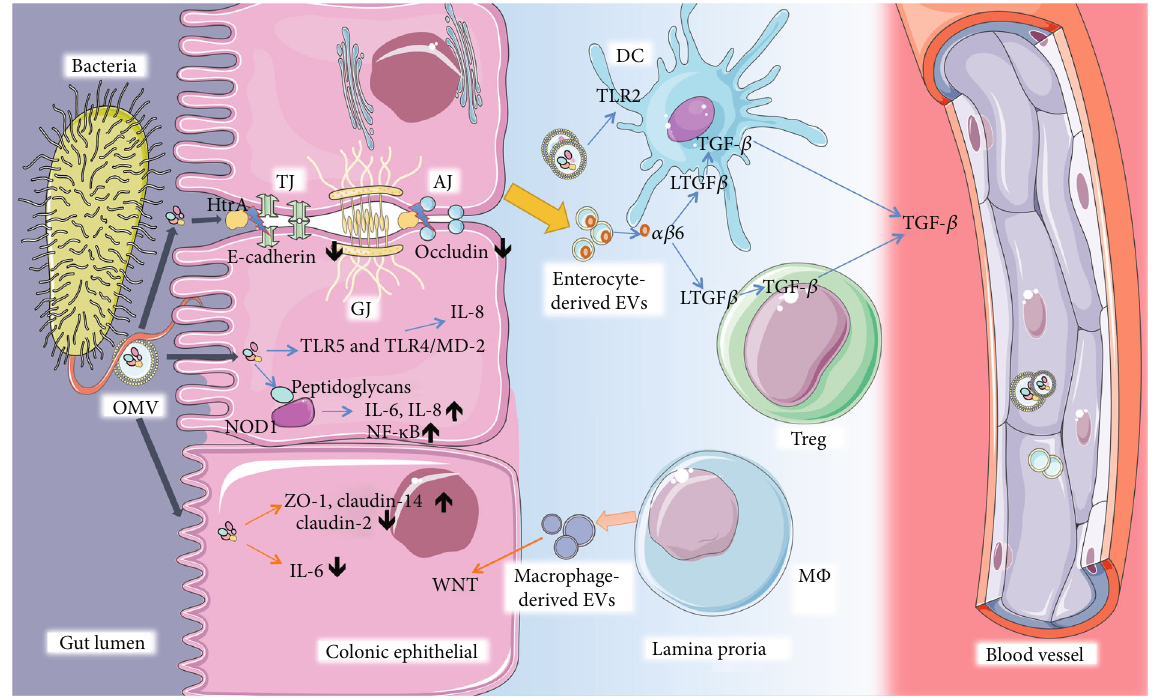
Figure 1: Classi fi cation of extracellular vesicles according to the mechanism of generation. Extracellular vesicles include exosomes, microvesicles, apoptotic bodies, out membrane vesicles, and membrane vesicles (not shown in the fi gure) in this review. Exosomes are produced by budding from multivesicular bodies. Microvesicles are generated intracellularly from the extracellular membrane. Apoptotic bodies are originated upon cell fragmentation during apoptotic cell